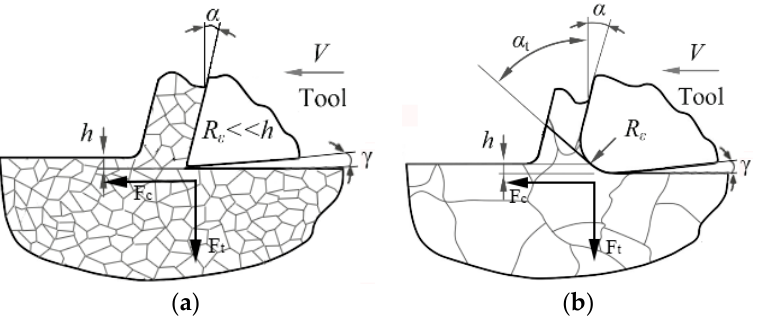
Figure 2. The effective rake angle during cutting process, F c means feed force and F t means thrust force. ( a ) Traditional machining manner; ( b ) micro-machining removal manner.